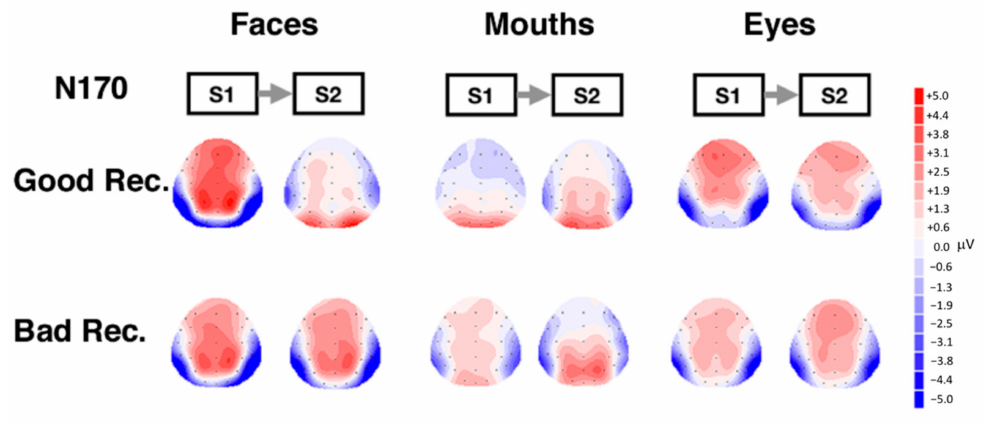
Figure 5. Topographical maps showing scalp distribution for the N170 component. Maps were generated by event-related potentials (ERPs) mean amplitudes measured in the N170 time window for S1 and